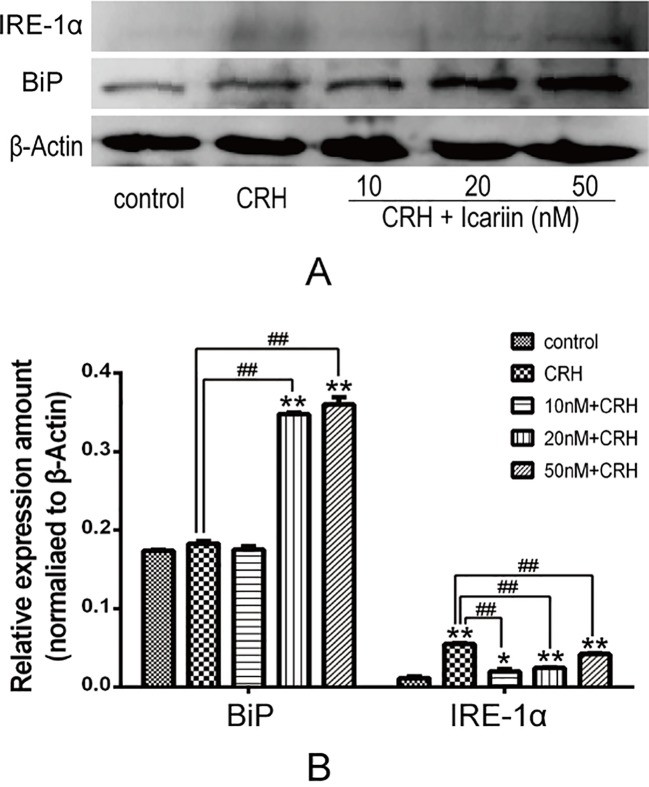
Icariin promoted BiP but suppressed IRE-1α protein expression. Primary cultured rat hippocampal neurons were pretreated with different concentrations of icariin (10, 20 or 50nM) for 2 h followed by treatment of CRH for 24 h. The immunoblotting (A) and the corresponding histogram (B) showed protein expression in different groups. *p < 0.05 and **p < 0.01 vs control; ##p < 0.01 vs CRH.